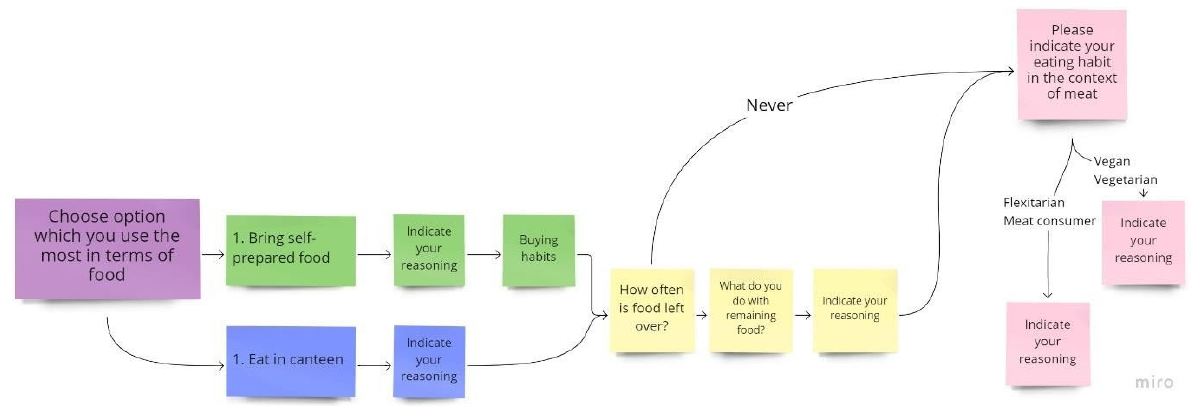
Figure 2. Skip ‐ logic algorithm for questions of “food category”. Figure 2. Skip-logic algorithm for questions of “food category”.